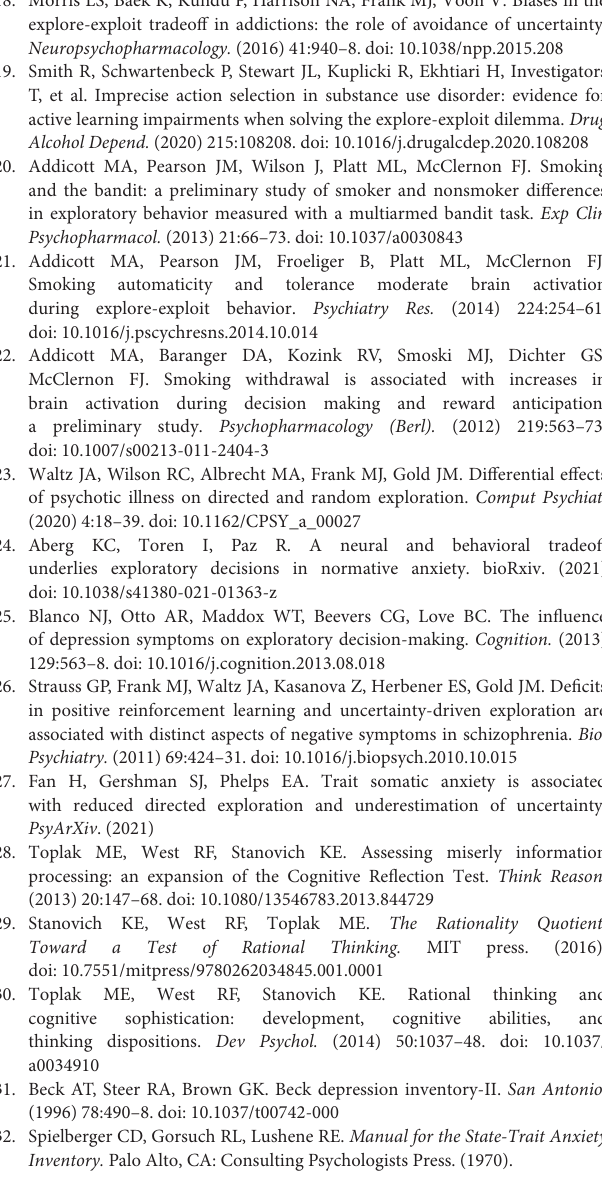
Supplementary Figure 1 | Post-hoc correlations (and associated BFs) between reflectiveness measures, symptoms, and Horizon Task measures. This is analogous to Figure 5 in the main text, but examines males and females separately – and suggests that observed relationships between directed exploration and symptoms were driven by females while relationships between directed exploration and reflectiveness measures were driven by males. Asterisks indicate BFs greater than 3, 10, 30, and 100, per conventional cutoffs for levels of evidence from moderate to extremely